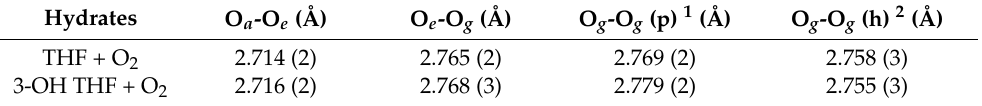
Table 3. Distances of host O-O atoms in the THF + O 2 and 3-OH THF + O 2 hydrates.